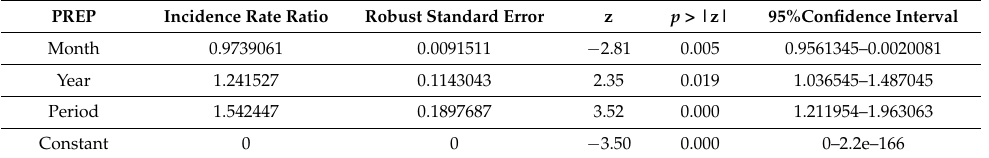
Table 4. Uptake of pre-exposure prophylaxis before and during the COVID-19